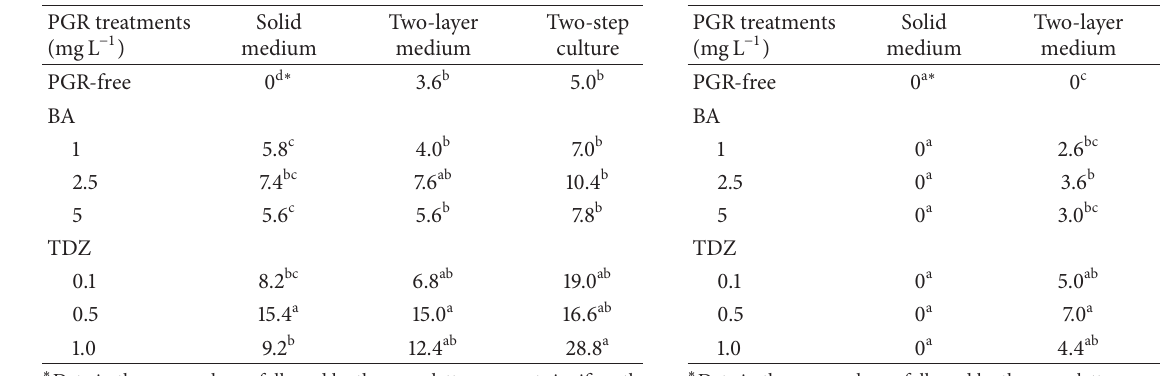
Table 1: Number of embryos formed on the distal site of shoots of 2-month-old seedlings, depending on culture systems and concen- tration of cytokinins.